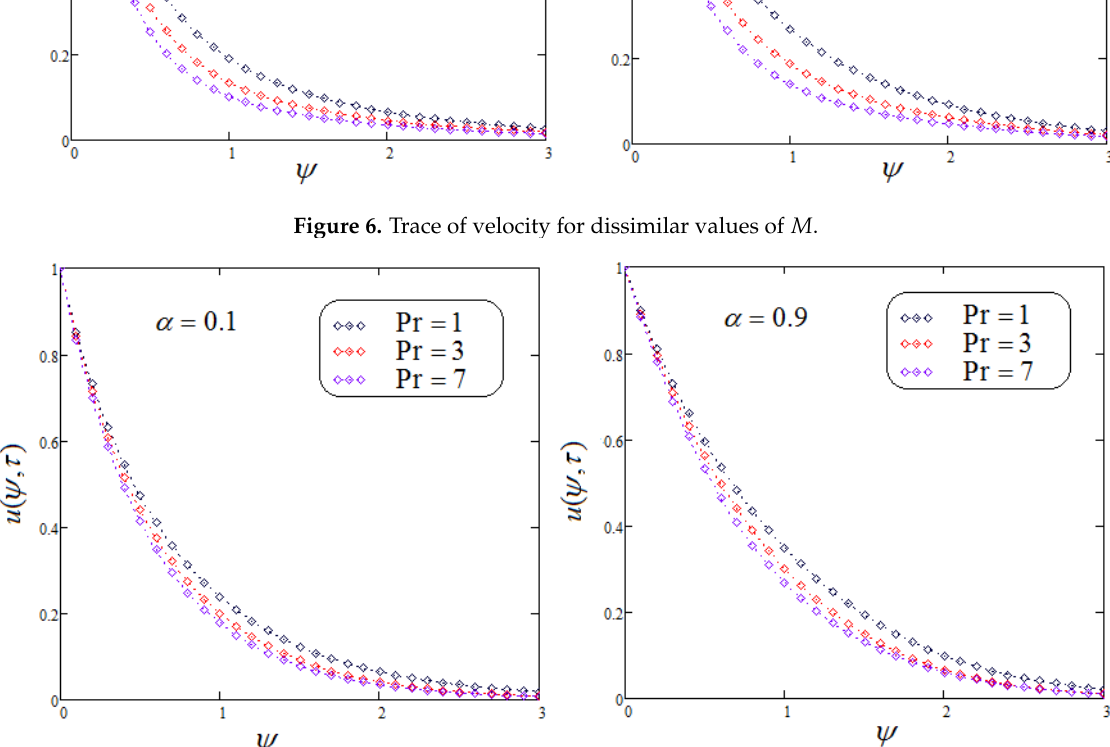
Figure 7. Trace of velocity for dissimilar values of Pr .